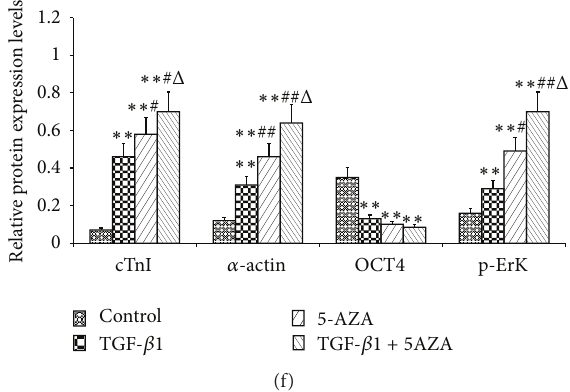
Figure 6: Protein expression levels of cTnI, 𝛼 -actin, p-ErK1/2, and OCT4. (a, c) The protein expression levels of cTnI in the different doses of cocktail. ∗∗ 𝑃 < 0.01 versus control group; # 𝑃 < 0.05 versus 3 𝜇 mol/L 5-AZA combined with 3 ng/mL TGF- 𝛽 1; Δ 𝑃 < 0.05 versus 10 𝜇 mol/L 5-AZA combined with 10ng/mL TGF- 𝛽 1. (b, d) The protein expression levels of cTnI at days 0, 7, 14, and 28 in the 5-AZA induction group and in the combination induction group. ∗∗ 𝑃 < 0.01 versus day 0; # 𝑃 < 0.05 , ## 𝑃 < 0.01 versus day 7; Δ 𝑃 < 0.05 versus day 14. (e, f) The expression levels of cTnI, 𝛼 -actin, p-ErK1/2, and OCT4 proteins in different treatment groups. ∗∗ 𝑃 < 0.01 versus control group; # 𝑃 < 0.05 , ## 𝑃 < 0.01 versus TGF- 𝛽 1 group; Δ 𝑃 < 0.05 versus 5-AZA group ( 𝑛 = 3